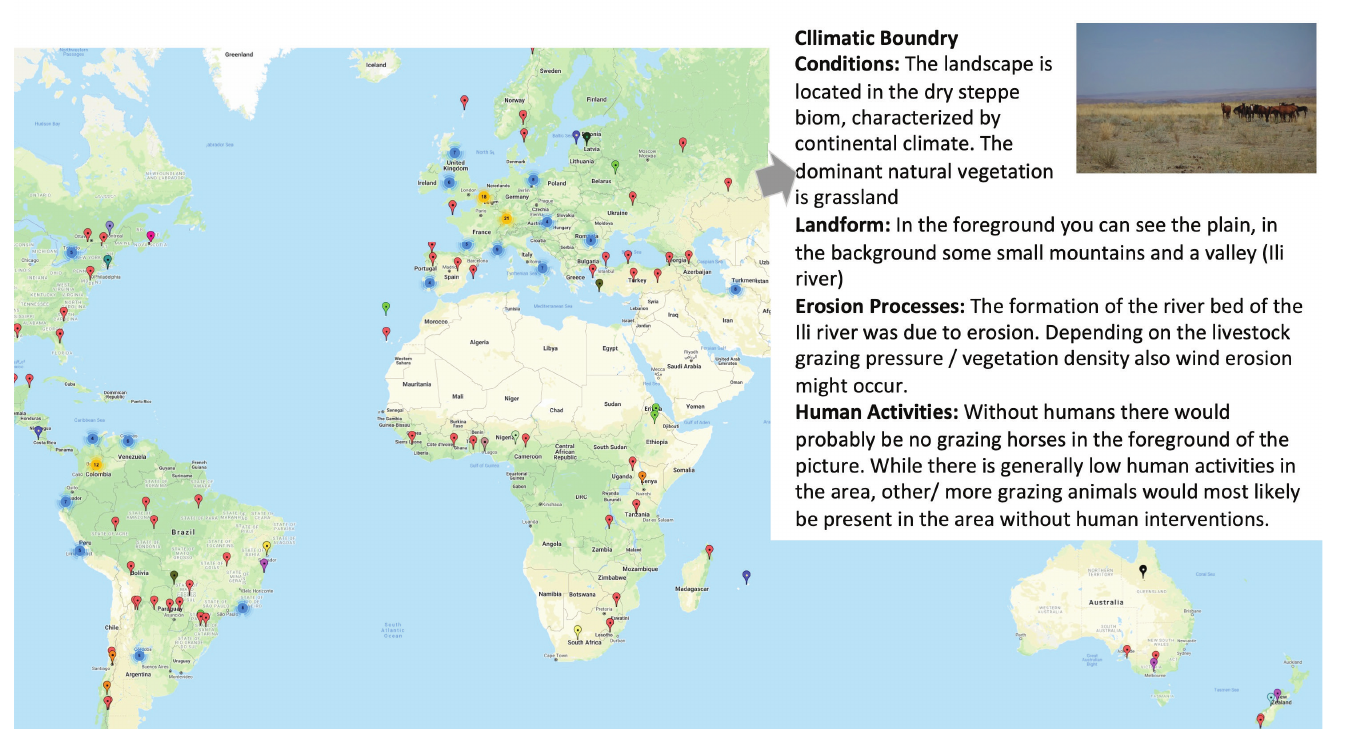
Figure 3: Example of a world map where students upload content. In this example the students describe the Drivers of Landscape Pattern in their home region. The symbols on the map represent the locations of 1 or more student contributions, details (as shown in the text box) are displayed when clicking on a